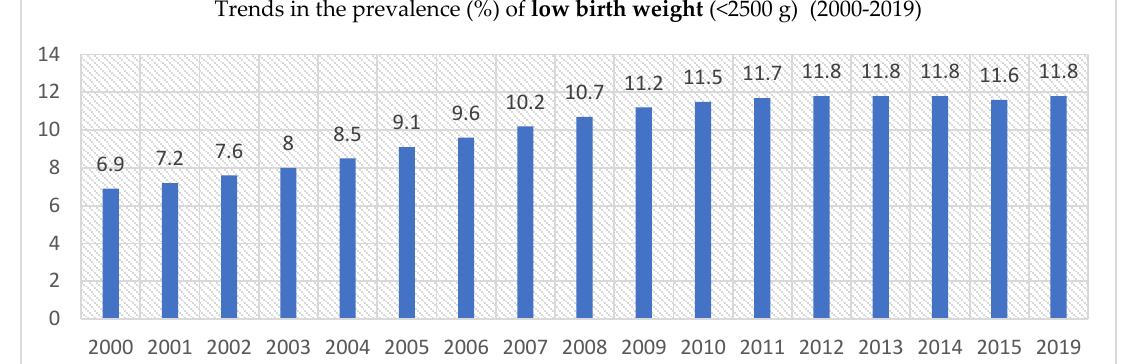
Figure 2. Trends in the prevalence (%) of low birth weight (< 2500g) in the UAE (2000 – 2019). Source: UNICIF/WHO: data.unicif.org, who.int/nutgrowthdb/LBW estimates, Statistic & Research Centre- MOHAP-2019, (Accessed on 5 December 2022) [29,44]. 3.2. Protein Energy Malnutrition (Stunting, Wasting, and Underweight) among Children